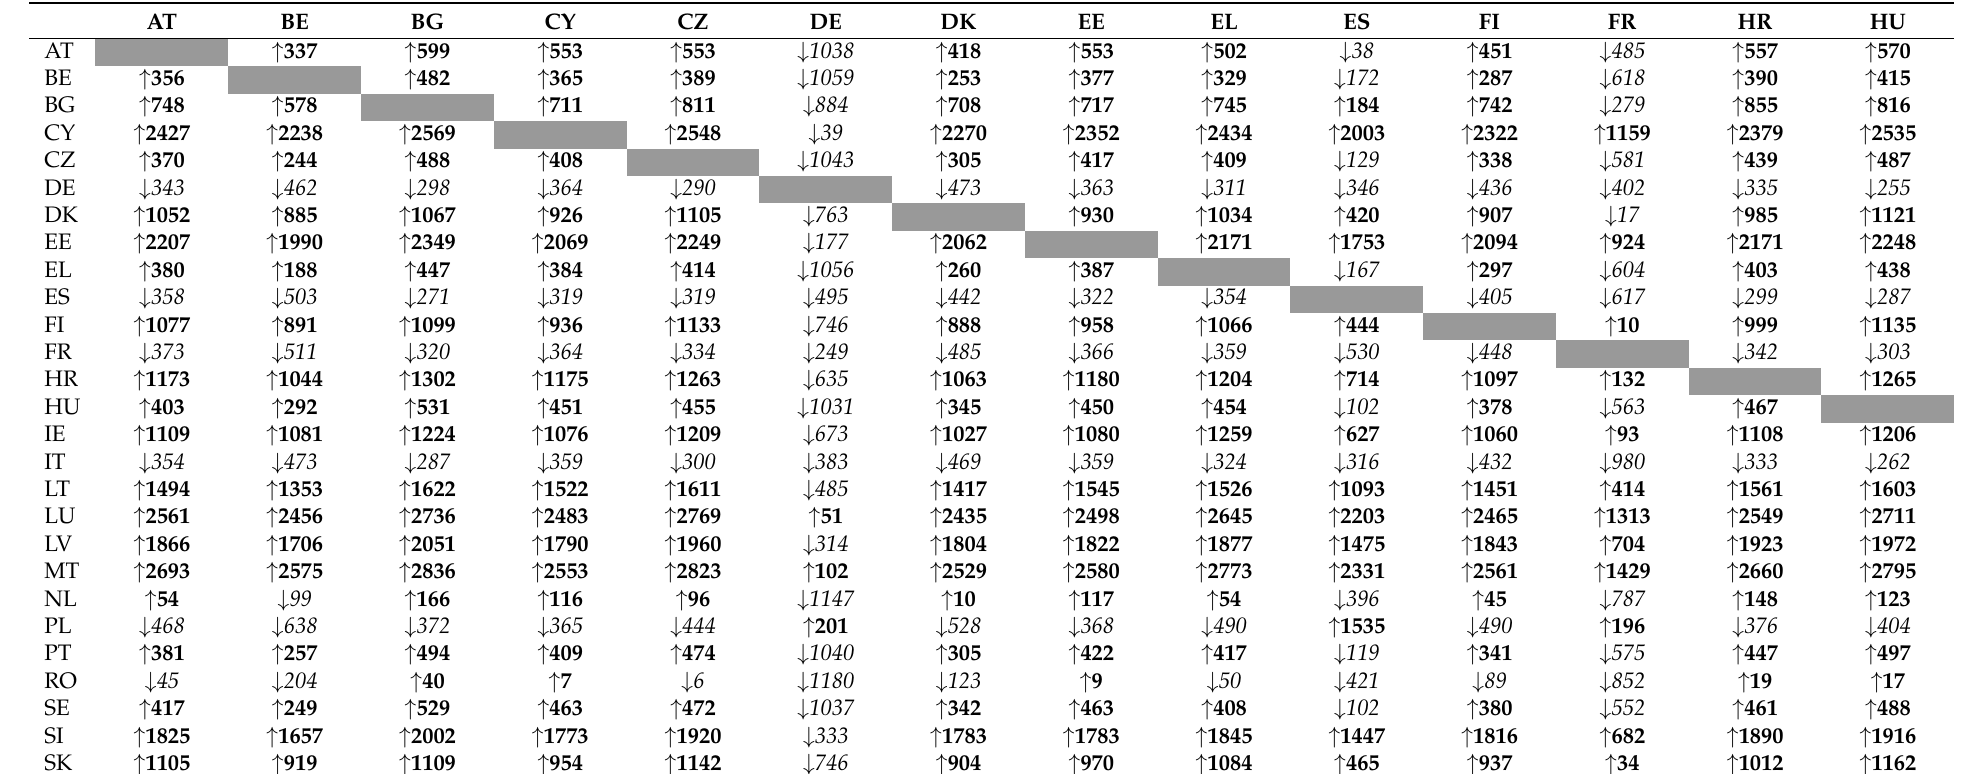
Table A2. The impact of additional departures to Brexit with populations for